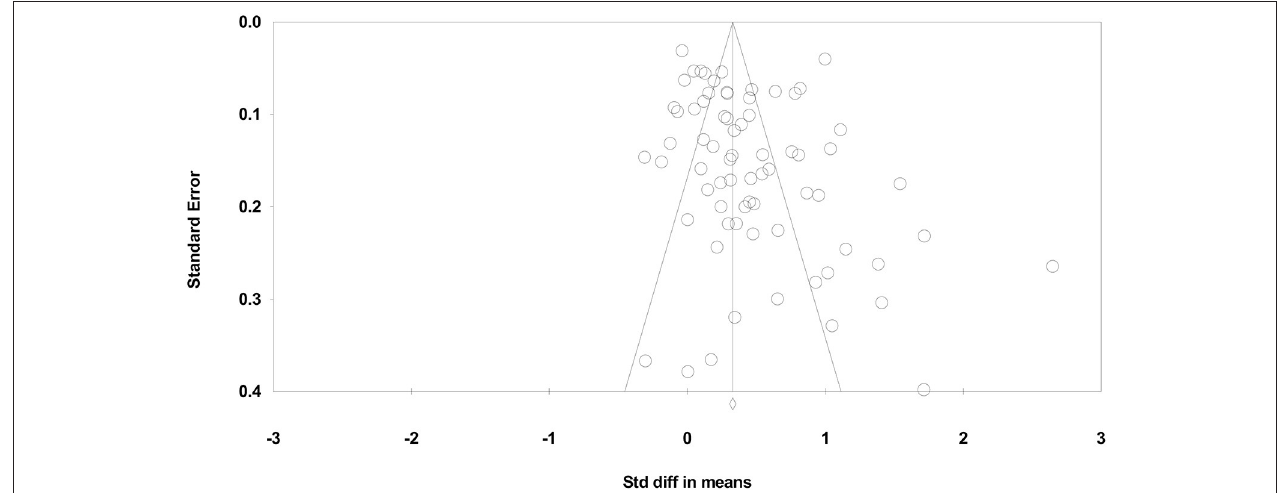
FIGURE 10 | Forrest plot of standardized difference in means of affective PE interventions.